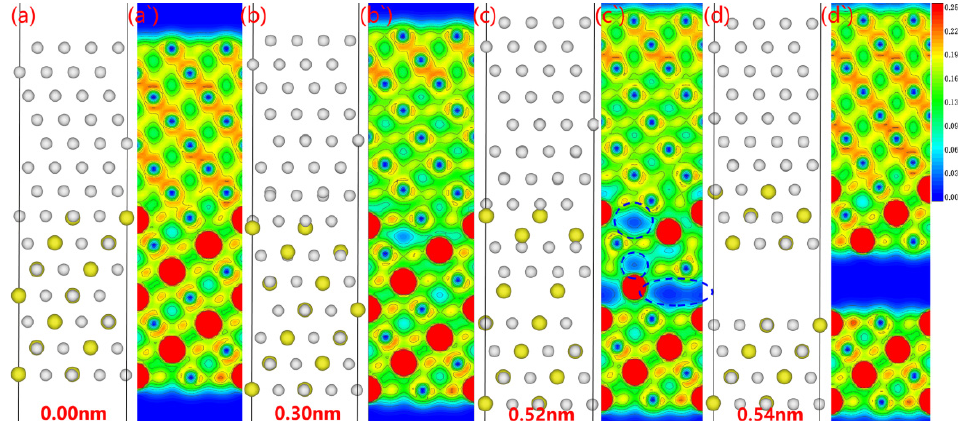
Figure 11. Fracture behavior and corresponding electron density of stretched Al 3 Y(111)|Al(111) system: ( a – d ) atomic site of the interface system, ( a` – d` ) electron density of the interface.